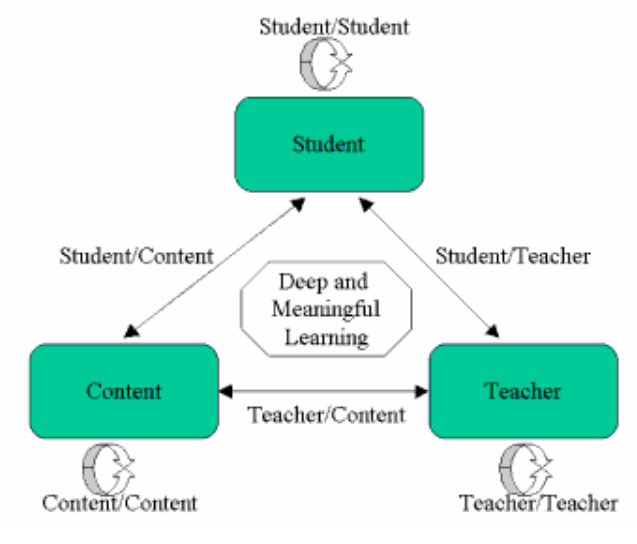
Figure 1. Modes of Interaction in Distance Education from Anderson and Garrison,